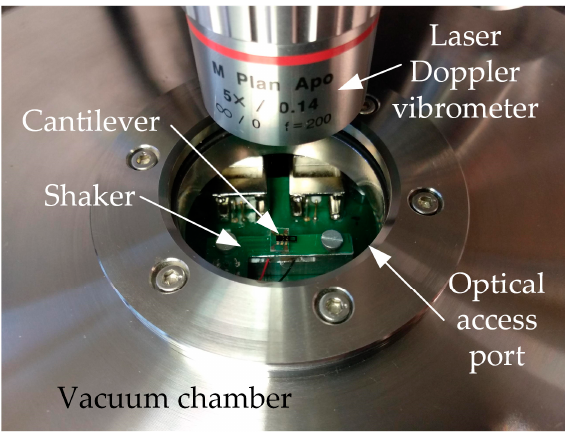
Figure 3. Photograph of the bonded MEMS cantilever mounted on a custom-built shaker. The complete set-up is placed in a vacuum chamber having optical access for the laser Doppler vibrometer (LDV) measurements.